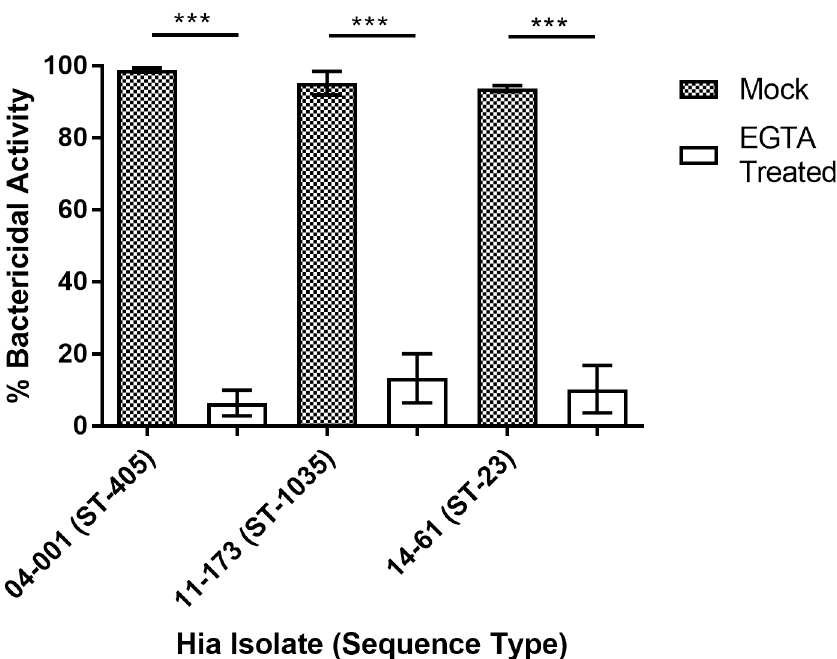
Fig 4. Serum sensitivity of Hia isolates following nullification of the classical complement pathway: The majority of the serum bactericidal activity is antibody mediated (classical complement pathway). Pooled human serum was mock or Mg 2+ EGTA treated and evaluated for bactericidal activity against select Hia isolates. Bars indicate mean percent bactericidal activity compared to heat inactivated sera ± SEM. Statistical significance was determined using Student’s two tailed t-test. (cid:3) P < 0.05, (cid:3)(cid:3) P < 0.01, (cid:3)(cid:3)(cid:3) P < 0.001. The graph is representative of two independent experiments, each performed in triplicate, which gave similar results.